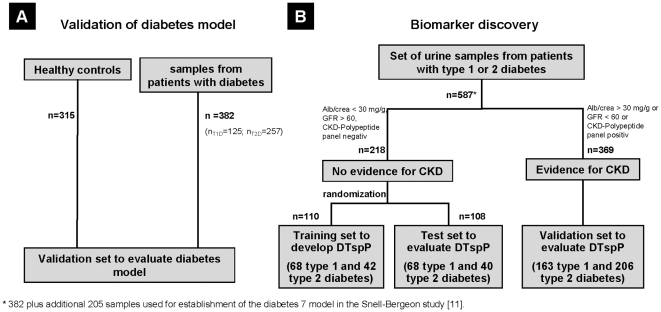
Study design.Flow chart describing the selection of samples used in this study. A: Urine samples from 697 individuals were analysed blinded, those contained 315 apparently healthy controls, and 382 urine samples from diabetic individuals. B: Samples from 587 well-characterized DM patients were used to identify DM type specific biomarkers. 382/587 samples were used for validation of previously described markers for DM.